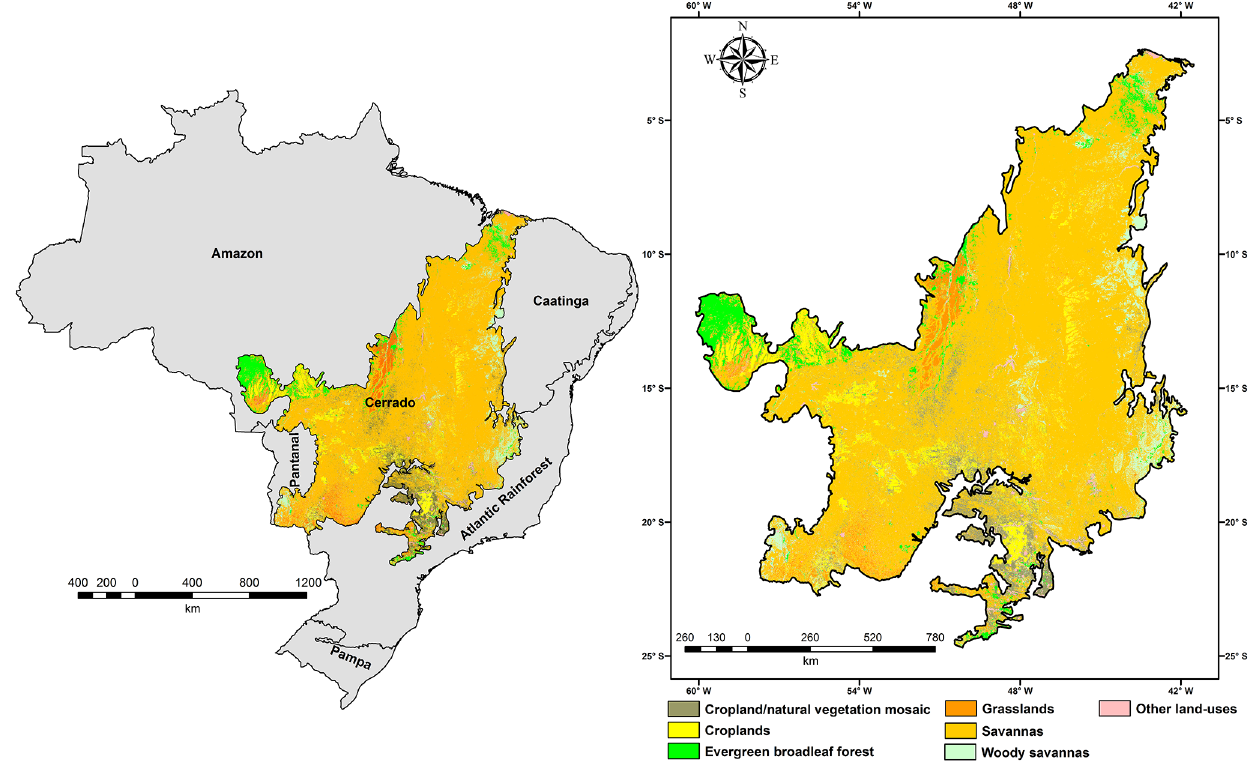
Figure 1. Location of the Brazilian biomes, highlighting the Cerrado biome. Most frequent LULC in the Cerrado estimated by the MCD12Q1 product during the 2002–2013